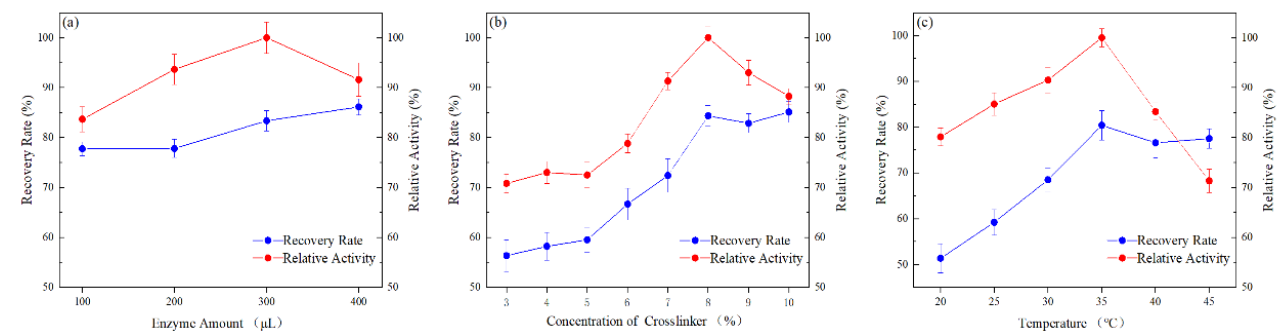
Figure 2. Optimization of: ( a ) enzyme loading, ( b ) crosslinker concentration, and ( c ) temperature. Glutaraldehyde was used as the crosslinker because it contains two aldehyde groups that can easily react with the amino function of proteins and form crosslinks [34]. Figure 2b shows the effect of the crosslinker amount. Initially, the enzymatic activity of the immobilized enzyme changed slowly, but when the concentration exceeded 5%, the enzymatic activity increased markedly. When the concentration reached 8%, the enzymatic activity of the immobilized enzyme reached its maximum, and the further addition of the crosslinking agent caused the enzyme activity to decline. This was likely due to the covalent bonding of the superfluous crosslinking agent to the active center of the enzyme, which caused the denaturation of the enzyme and thereby reduced the enzyme activity. A contributing factor might be the increased steric hindrance caused by the immobilization of enzyme molecules, which restricted the access of the substrate to the active center.